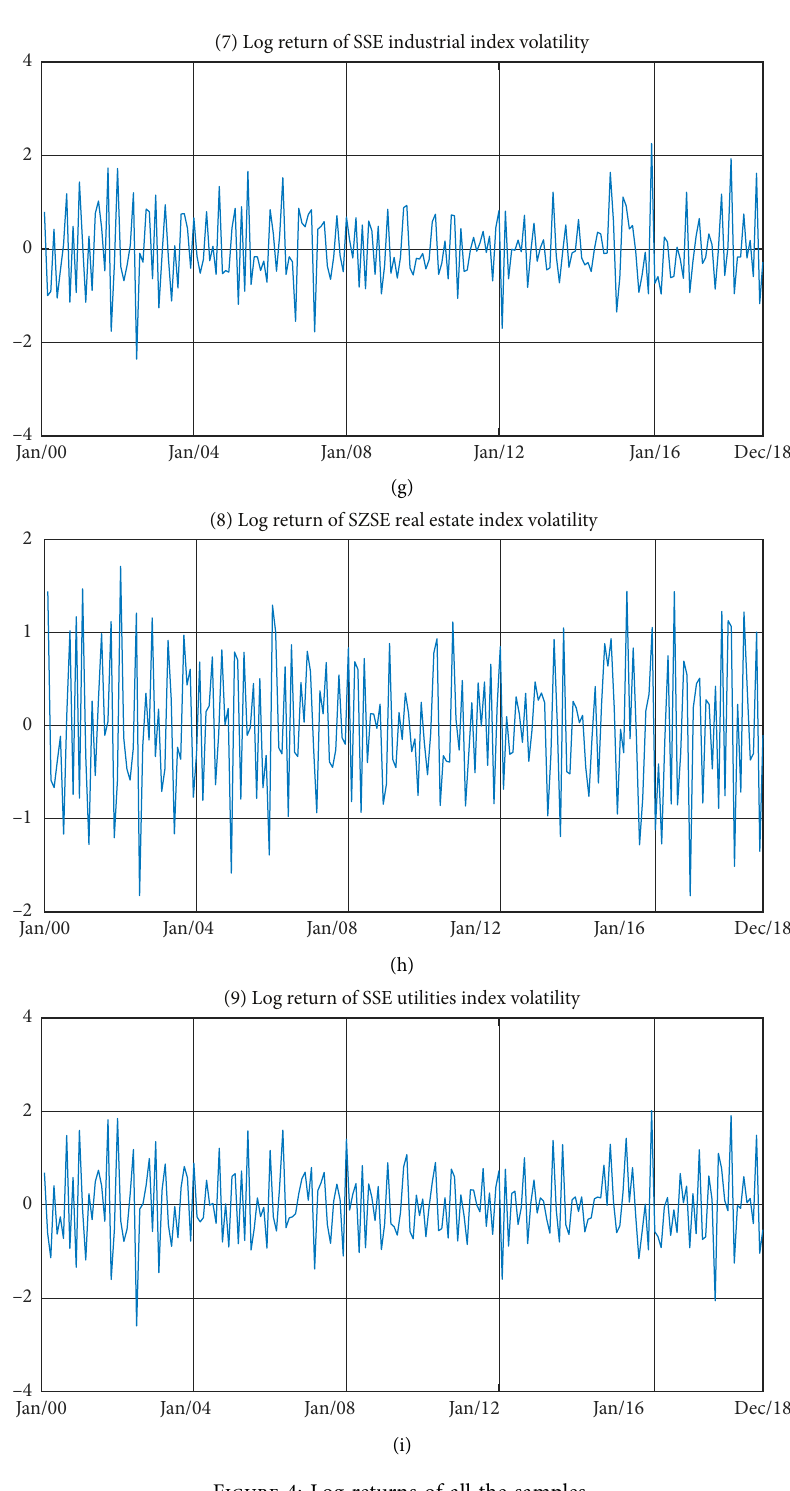
Figure 4: Log returns of all the